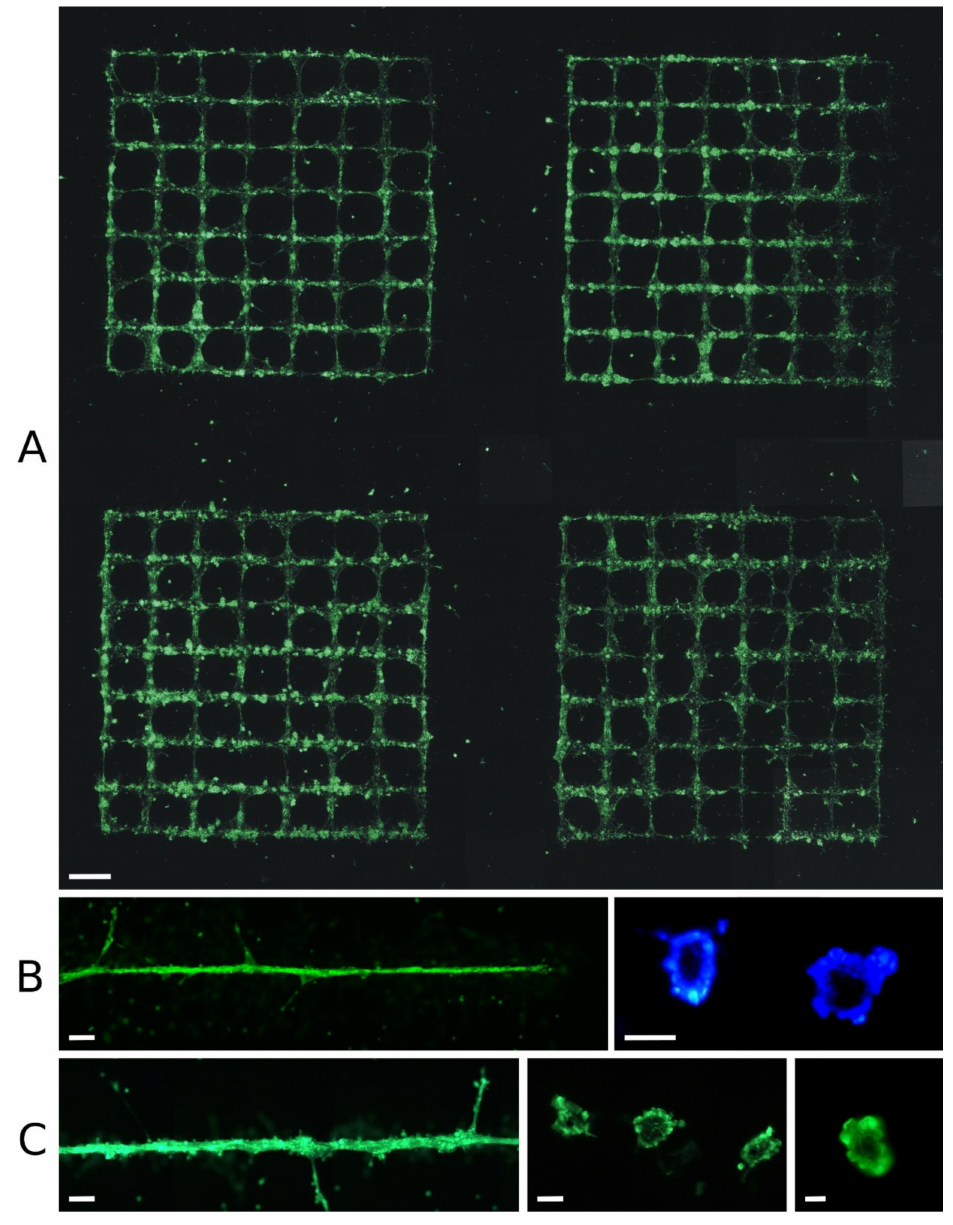
Figure 2. Vessel formation on Matrigel within 24 h. Green fluorescent endothelial cells (HPMECs, GFP-labeled) printed in patterns of grids ( A ) or as a line ( B , C ) on Matrigel. Each image was taken 24 h after printing. In rows B and C on the right-hand side there are cross-sections of printed HPMEC vascular structures, which were additionally stained with Hoechst 33,342 ( B ); the printed cells formed a tubular structure with a lumen. In principle, printing of more complex patterns (such as the grids shown in ( A )) is possible; however, none of the grids is perfect—each has breaks in lines where cells have disappeared and other places where cells have formed larger agglomerates. Some cells have moved significantly away from their printed position. The applied laser pulse energy was 6 µ J, and the patterns in panels ( A , C ) on the left were printed twice in the same place. Scale bars are 1 mm ( A ), 200 µ m ( B left and C left), 50 µ m ( B right and C center), and 10 µ m ( C